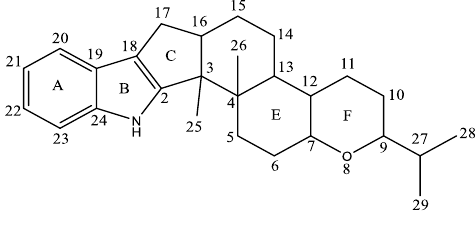
Figure 2. Indole diterpene